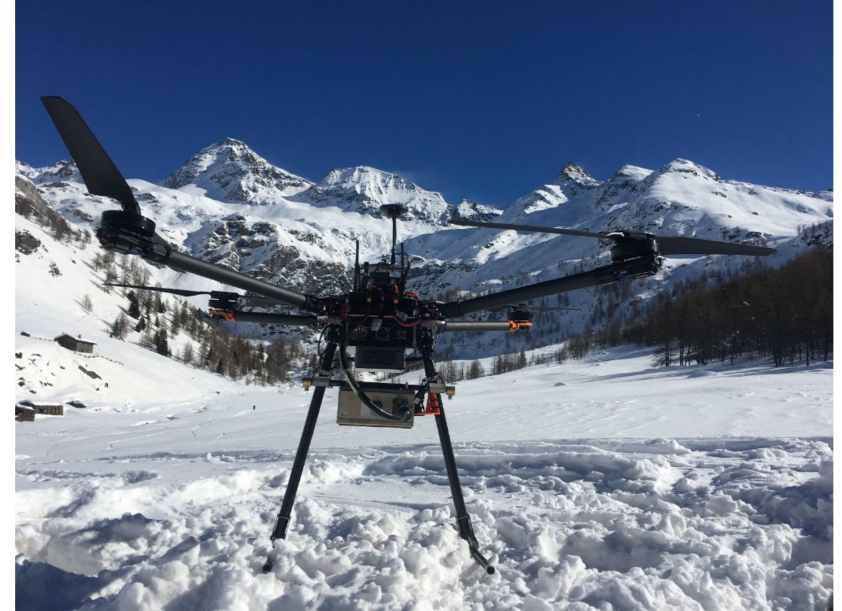
Figure 2. The drone deployed in the Cheneil survey